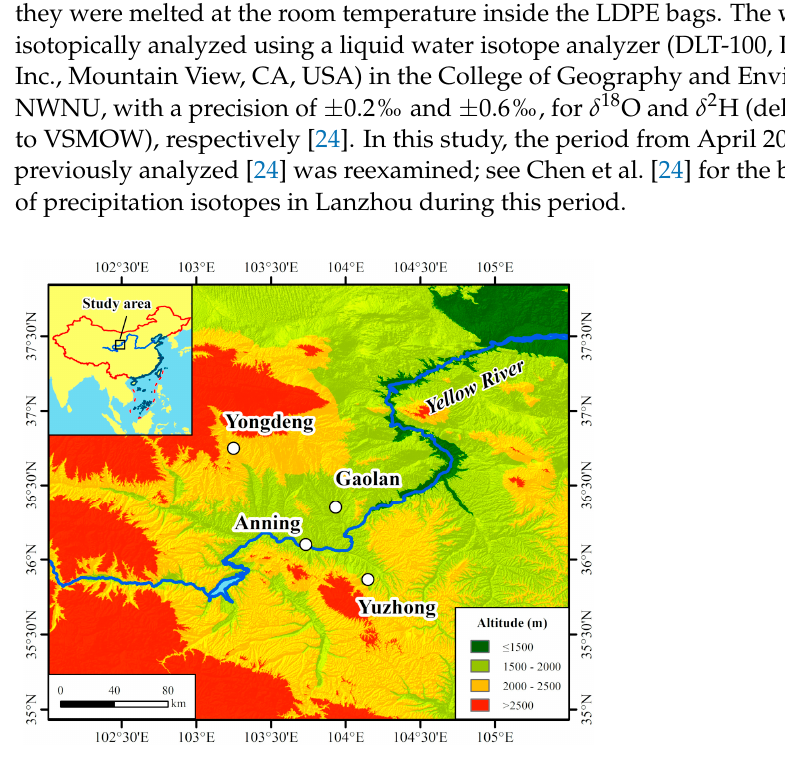
Figure 1. Spatial distribution of network in Lanzhou used in this study. Small map shows the study area in China.